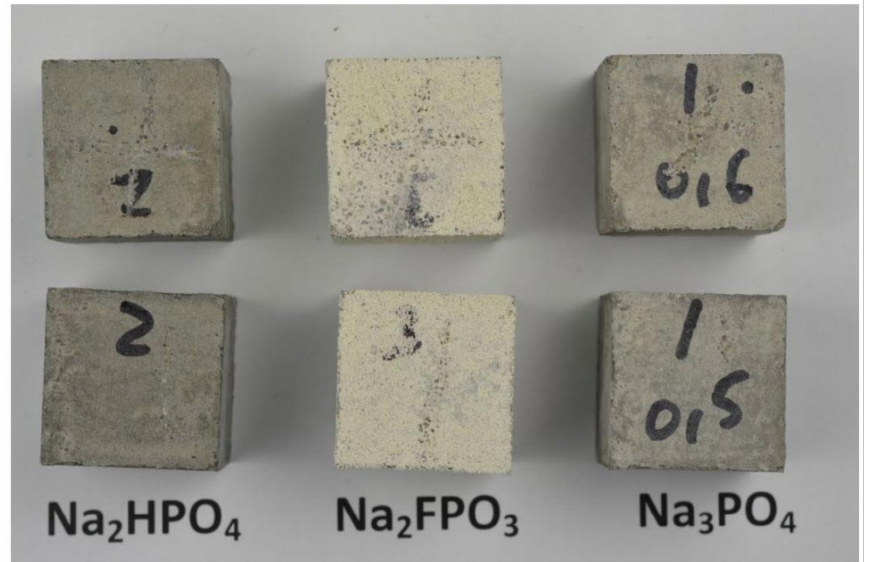
Figure 27. Specimens exposed to 5 wt.% Na 2 HPO 4 (DHP), Na 2 PO 3 F (MFP) or Na 3 PO 4 (TSP) for 40 days [43]. Reproduced with permission from Bastidas, D.M. et al., Cem. Conc. Comp.; published by Elsevier,